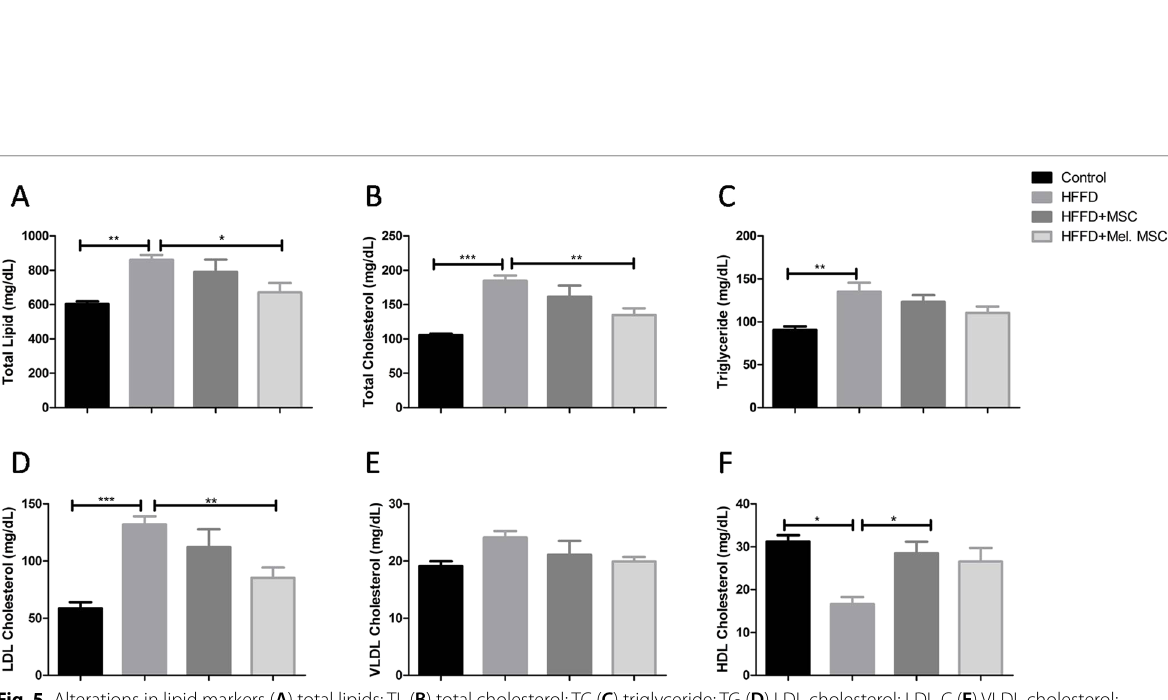
Fig. 4 Alterations in serum ( A ) glucose and liver markers ( B ), AST ( C ), ALT ( D ) ALP on high-fat high-fructose diet (HFFD), HFFD mesenchymal stem cell (MSC) therapy (HFFD mean